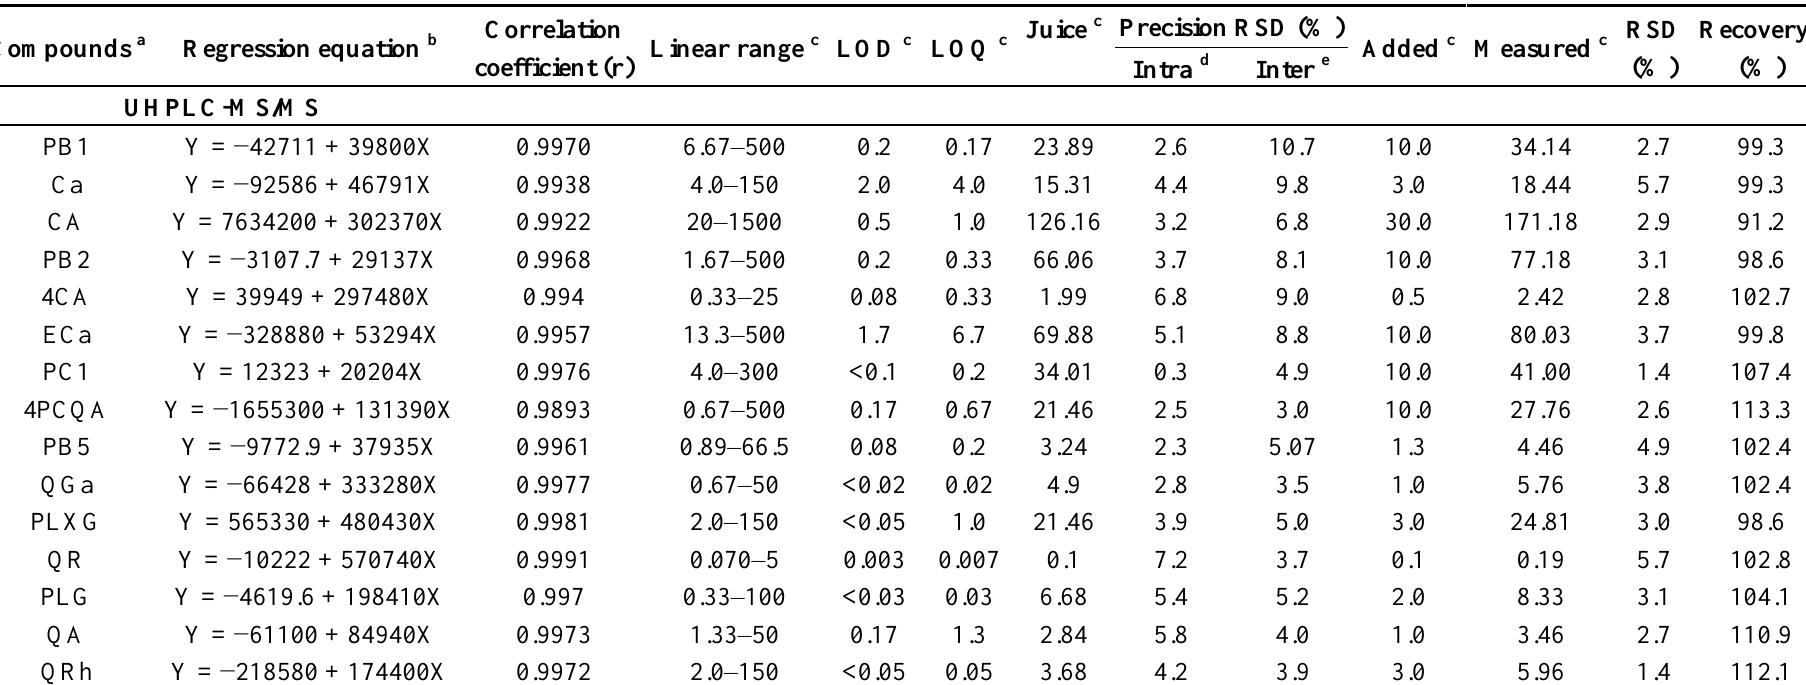
Table 2. Calibration curve parameters for the 15 major phenolic compounds according to MS detection and results of the validation study for P12R3A28 apple